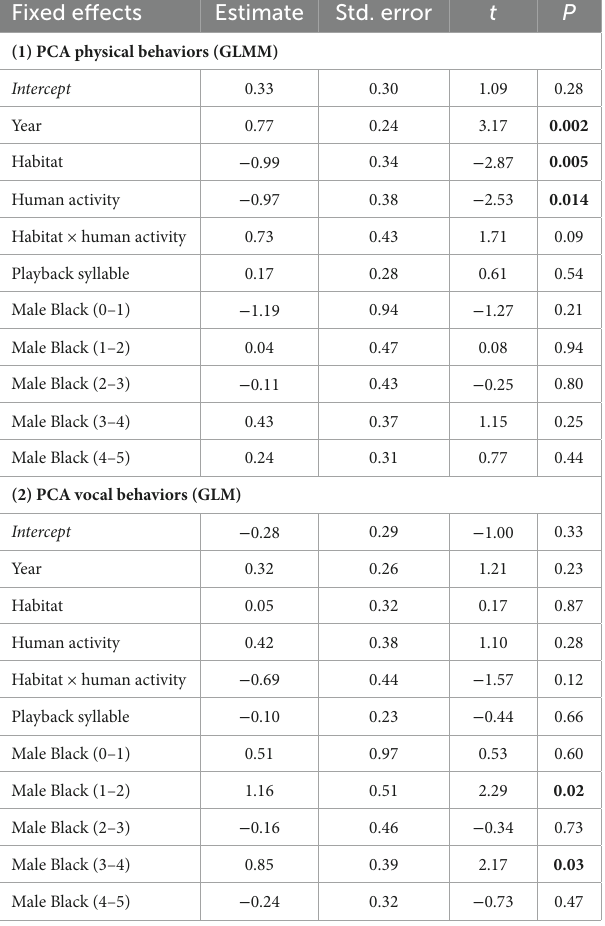
TABLE 3 Output from the GLMM and GLM testing whether year, habitat, human activity, habitat × human activity correlated with playback response in small ground